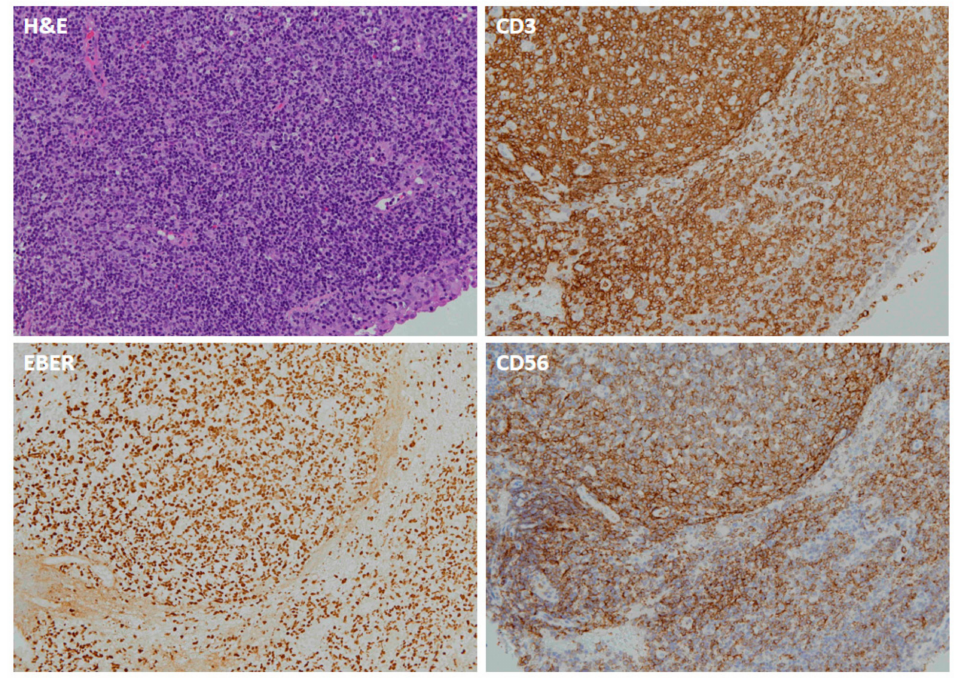
Figure 5. Pathologic images of NP-NKTCL. The H&E-stained slide shows di ff use proliferation of small to medium sized lymphoid cells. The neoplastic lymphoid cells are positive for CD3, CD56, and